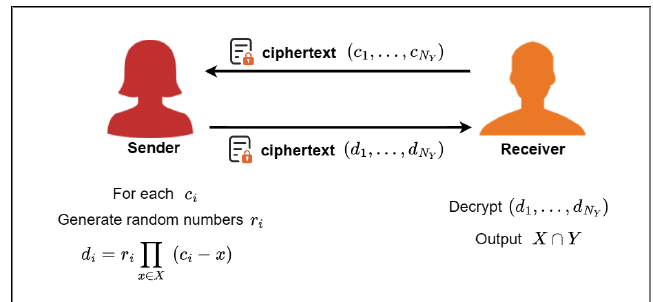
Figure 1. Basic PSI protocol.